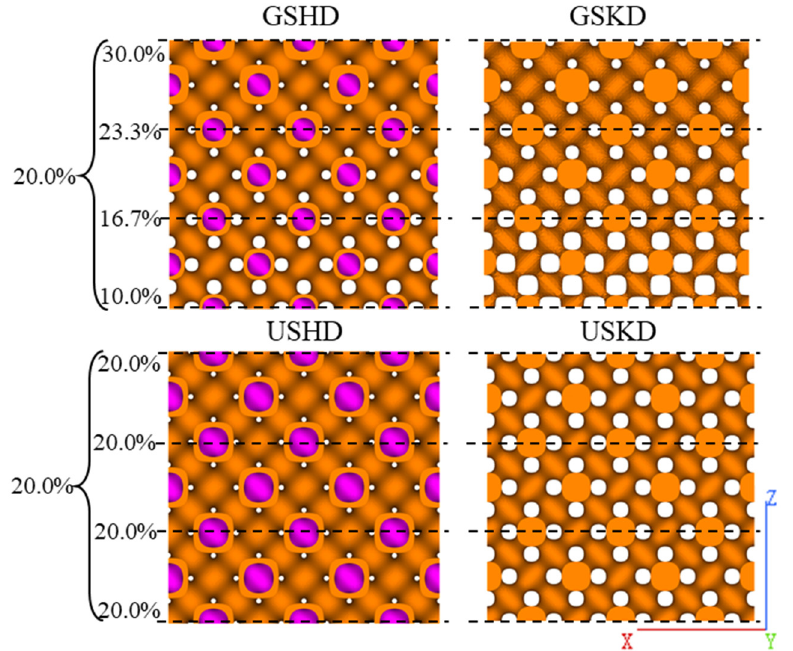
Figure 1. Front view of the four designed Diamond structures.